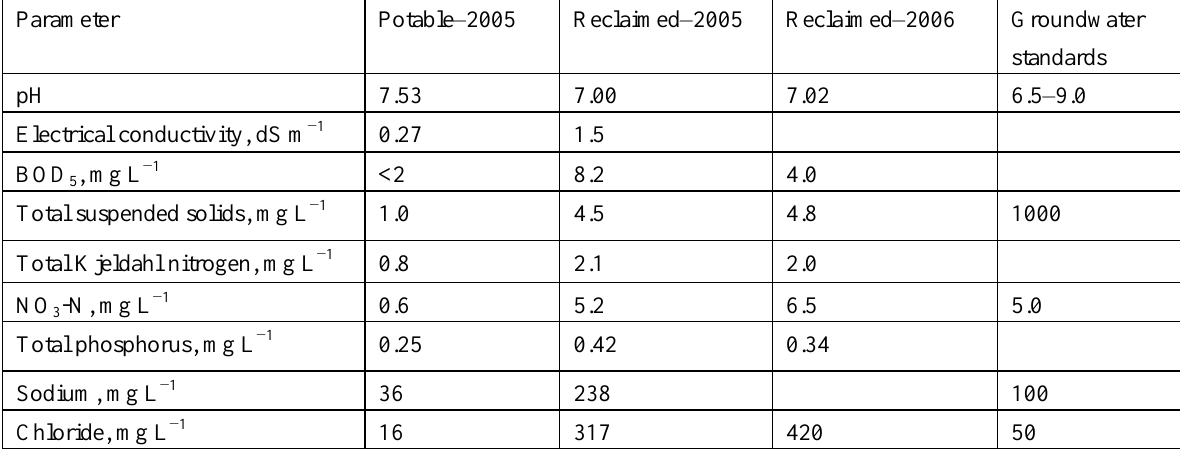
Table 1. Chemical and physical analysis of potable (2005) and reclaimed, non-potable (2005 and 2006) water used to irrigate the turfgrass, and groundwater standards for southeastern Virginia. Values are means of analyses conducted several times per week throughout the application